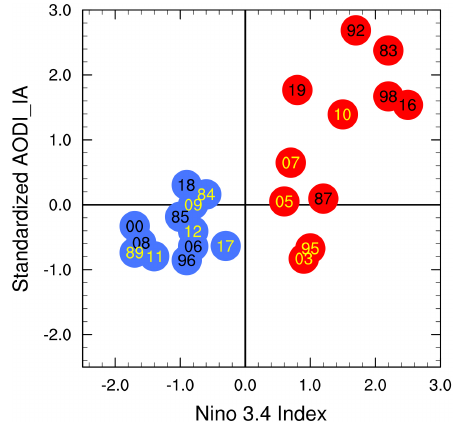
Figure 11. Scatter plot between standardized AODI_IA and cor- responding preceding winter (DJF) Niño 3.4 ( ◦ C) indices for 23 ENSO events. A total of 11 El Niño and 12 La Niña events are indi- cated by red and blue circles, respectively. The number inside each circle denotes the calendar year, with black and yellow for EP and CP ENSO,